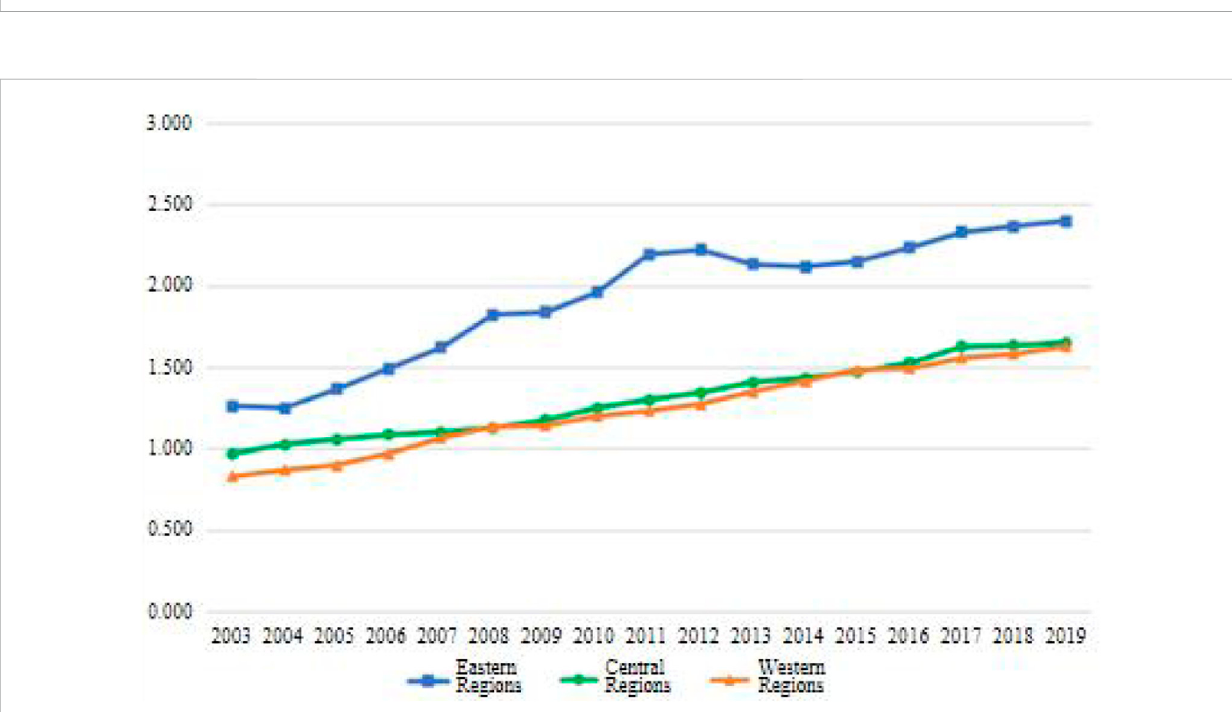
FIGURE 2 Trends in the level of technical progress in the service industry in China and in the Eastern, central, and Western regions.